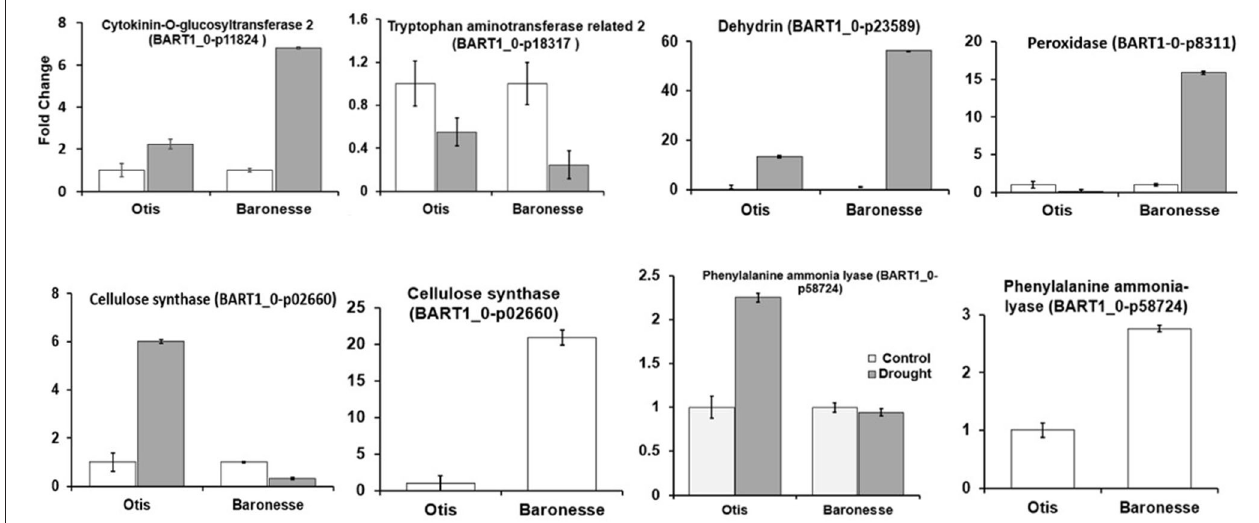
FIGURE 8 | Quantitative real-time PCR validation of RNA-seq data for selected genes.